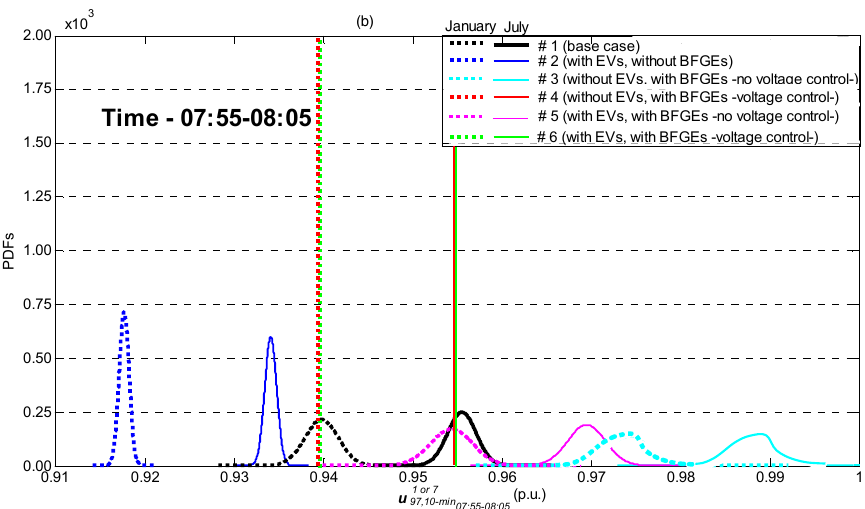
Figure 9. PDFs of the 10-min voltage magnitude at node 97 in different scenarios. ( a ) around 00:00 h; ( b ) around 08:00 h.